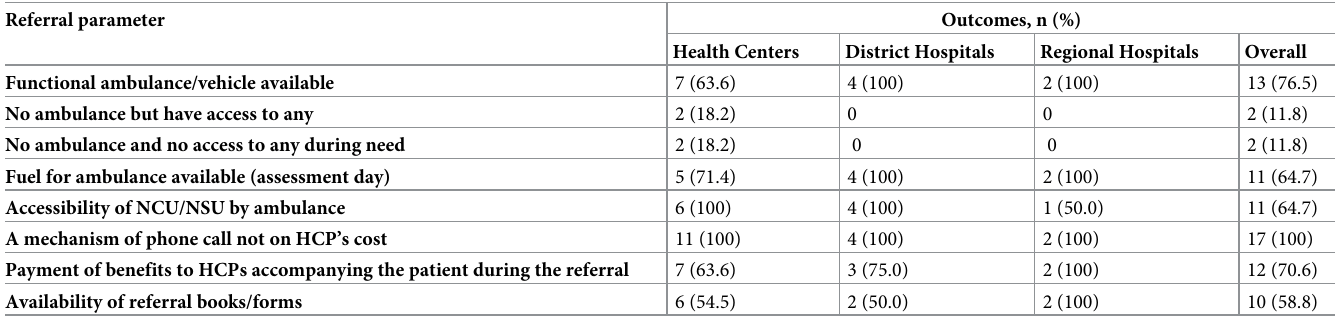
Table 7. Status of the referral system (N =